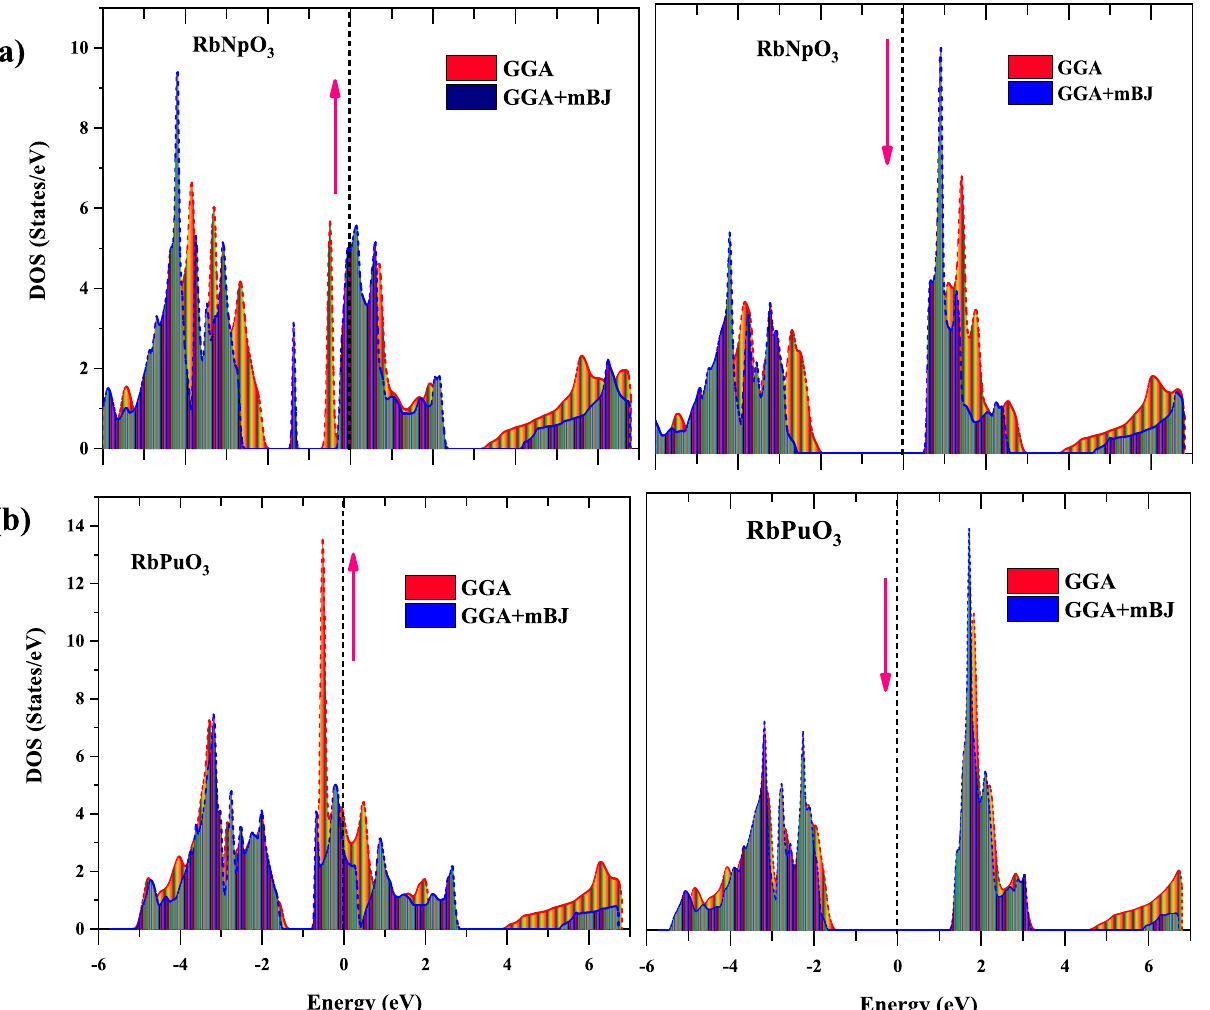
Figure 4. Total density of states (TDOS) predicted by GGA and GGA + mBJ approximations for ( a ) RbNpO 3 and ( b ) RbPuO 3